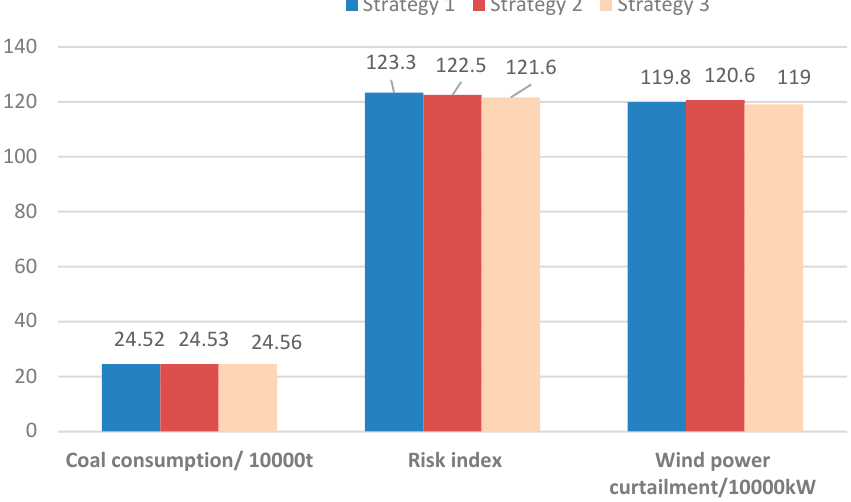
Figure 11. Scheduling results under different management strategies for battery energy storage.